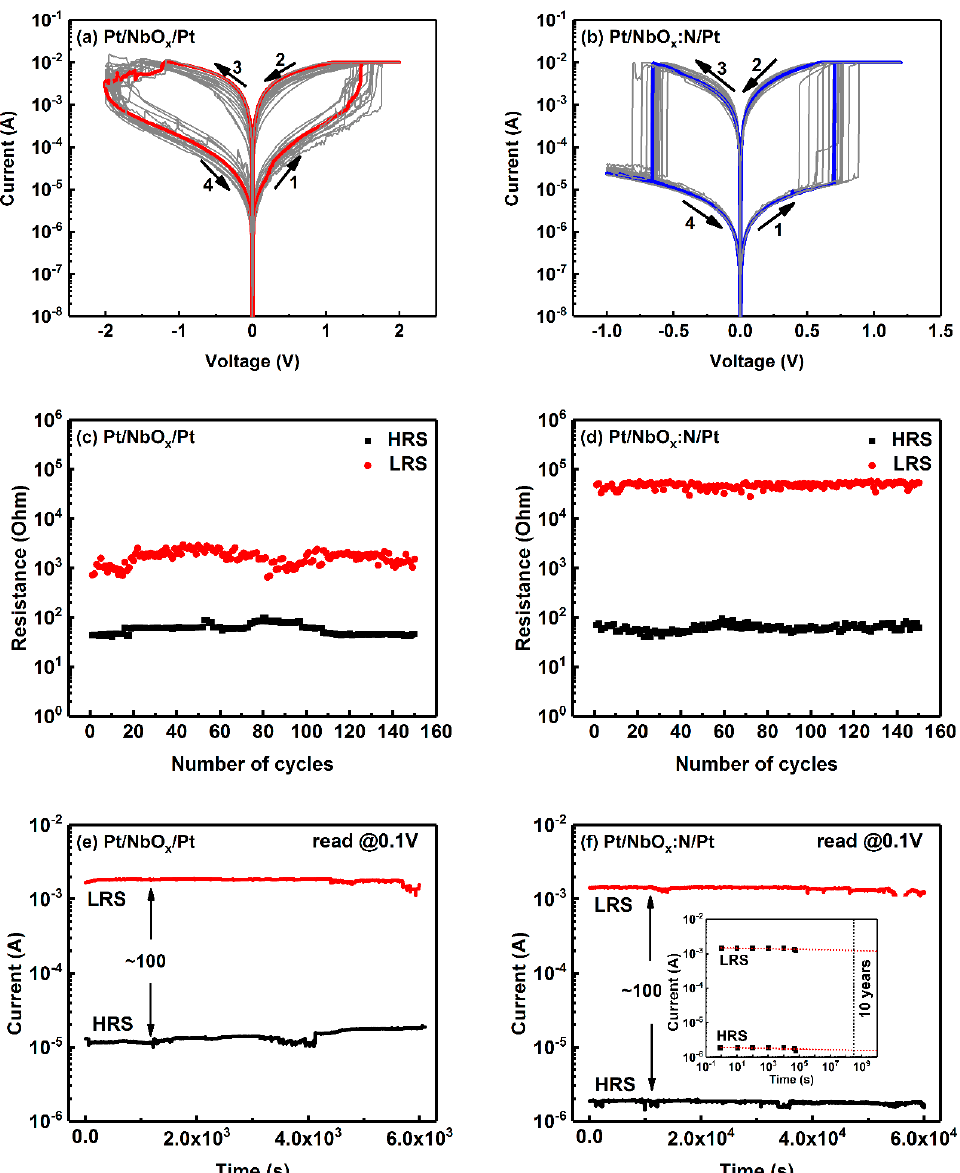
Figure 5. ( a ), ( b ) Semi-logarithm I-V curves with sweeping voltages between 1.5 V and − 1.5 V; ( c ), ( d ) resistance distribution with the number of cycles, retention time of low-resistance state (LRS) and high-resistance state (HRS) at a voltage of 0.1 V for the ( e ) Pt/NbO x /Pt and ( f ) Pt/NbO x :N/Pt memory devices, respectively. The inset graph in ( f ) is the linear extrapolation fitting of retention time for the Pt/NbO x :N/Pt memory device.